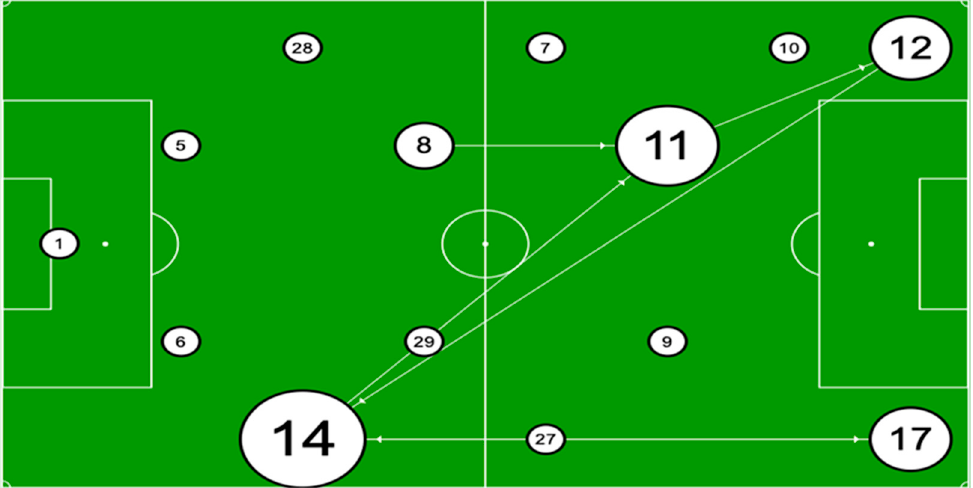
Figure 4. Network display results from team B in the critical event L3 .